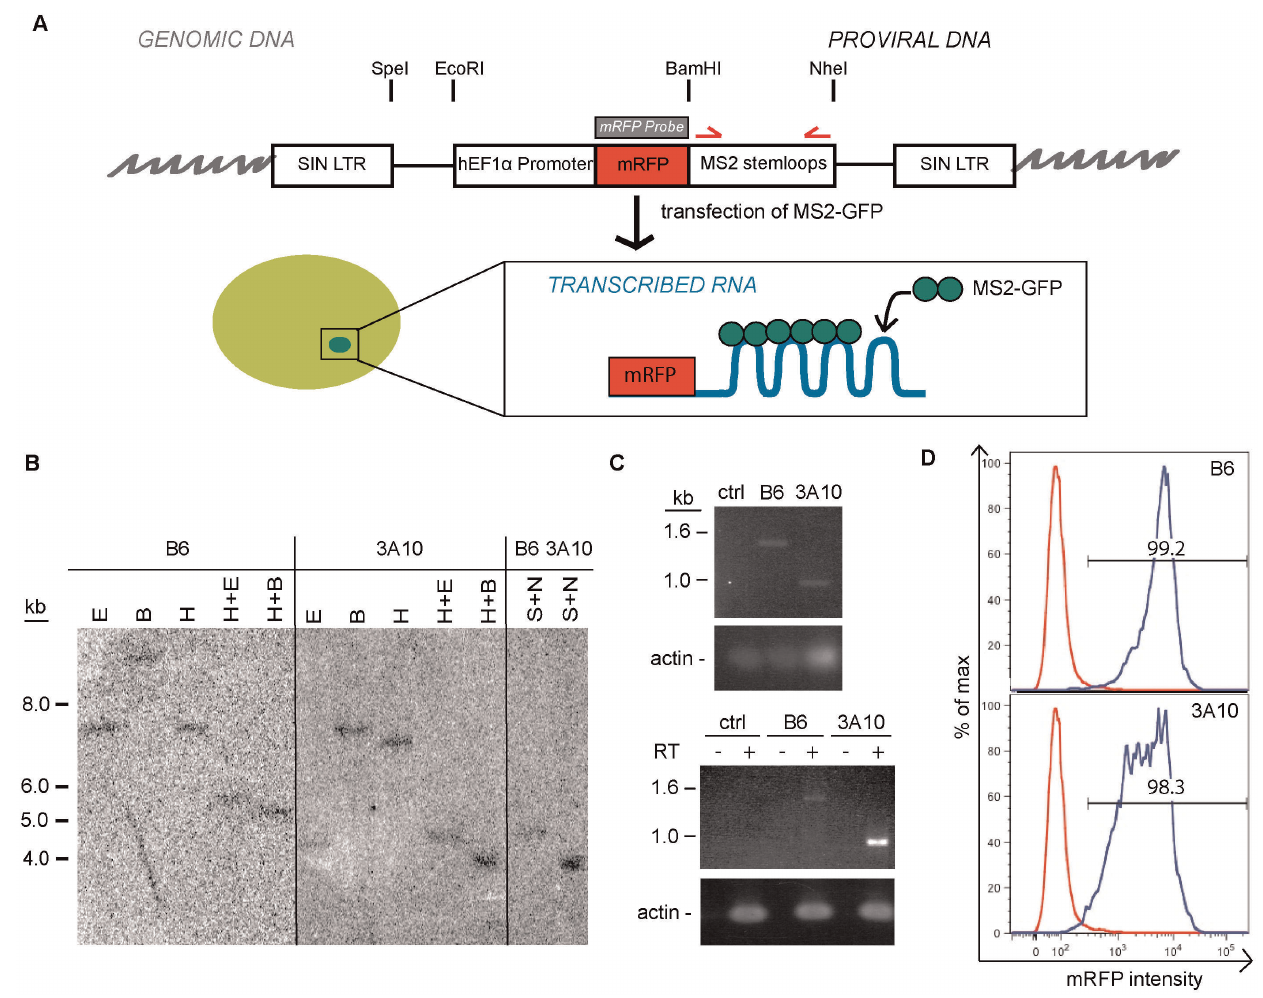
Figure 1. Development of the MS2 system to detect transcription sites of a retroviral transgene. A. Schematic diagram for detecting transcription sites from retroviral transgenes. The MS2 stem-loop was inserted into a HSC1 retrovirus backbone expressing mRFP. The structure of provirus after integration into the genome is shown. Location of restriction enzymes digestion sites, probe used for southern blot analysis (gray box) and primers for PCR (red arrows) to confirm size of stem-loops are indicated. B. Southern blot analysis of genomic DNA from Clone B6 and 3A10 of infected ES cells digested with various enzymes. (E= Eco RI, B= Bam HI, H= Hind III, S= Spe I, N= Nhe I) Digested DNA was hybridized to the mRFP probe. No Hind III site is found within the provirus. C. PCR analysis of number of stem-loops integrated into the genome in the two clones (top) and the number of stem-loops transcribed from each clone (bottom). Uninfected J1 ES cells were used as a control. Actin was used as a loading control. D. Flow cytometry histograms showing expression of mRFP in Clone B6 (top) and Clone 3A10 (bottom). Red line denotes uninfected control J1 cells and blue line indicates clone being interrogated.